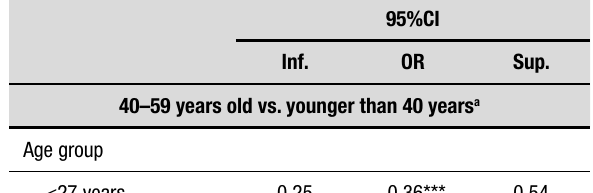
Table 5. Demographic and social factors associated with best age group to start adopting risk reducing